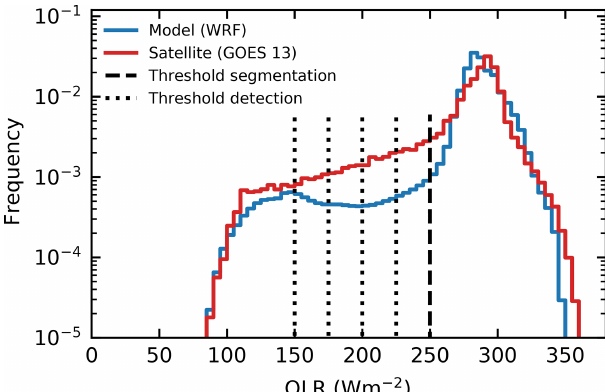
Figure 7. Probability density function of OLR for the model sim- ulation and the satellite retrievals including the thresholds (vertical dashed and dotted lines) set for feature detection and